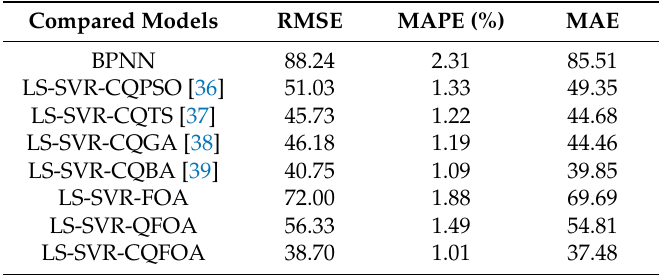
Table 9. Forecasting indexes of LS-SVR-CQFOA and other models for GEFCom2014 (July).